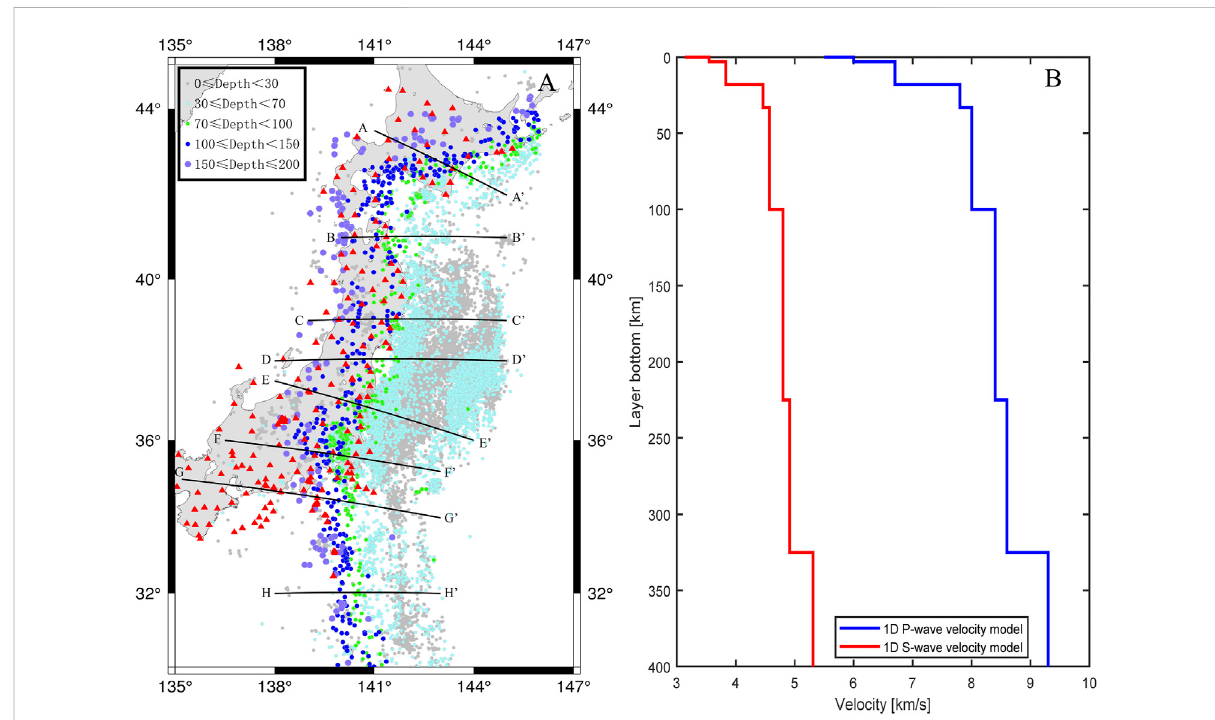
FIGURE 2 (A) Spatial distribution of the data set and 8 pro fi les location shown on the inset map. (B) The One-dimensional initial velocity